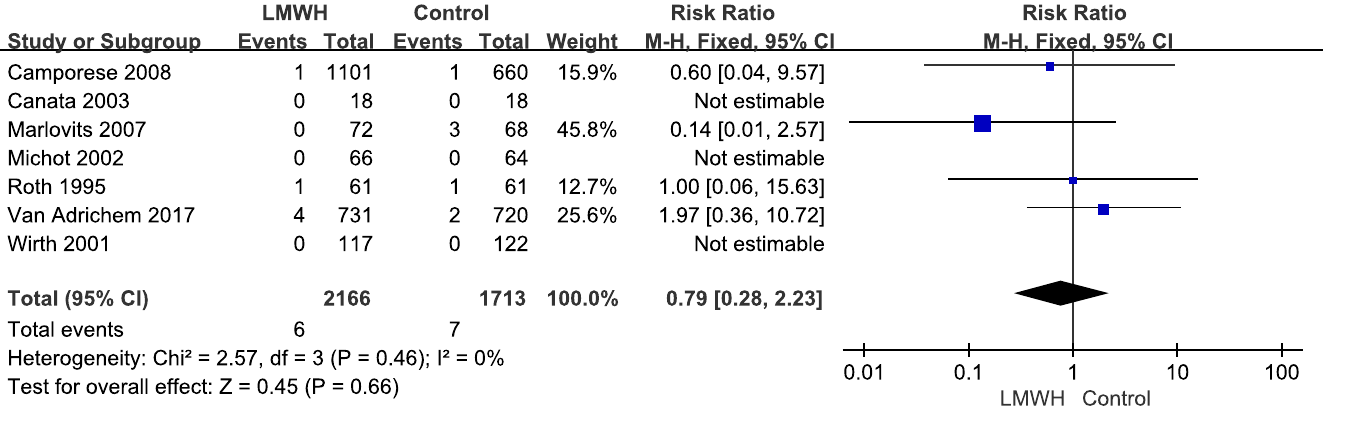
Fig 5. LMWH versus control. Symptomatic deep vein thrombosis during follow-up.